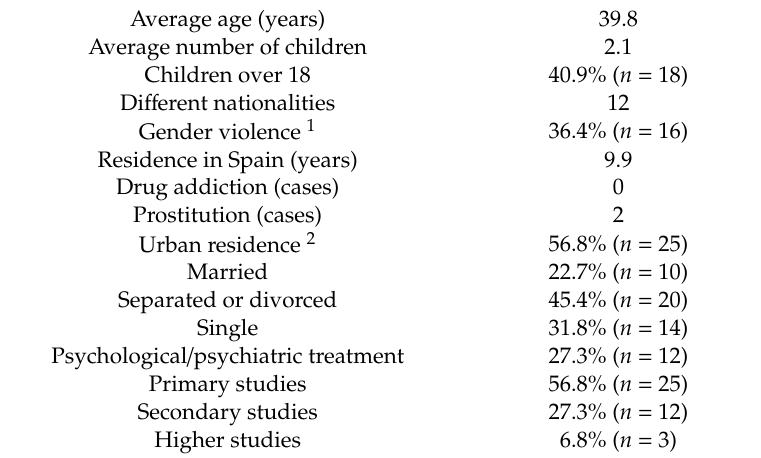
Table 1. Social profile of the participants ( n =